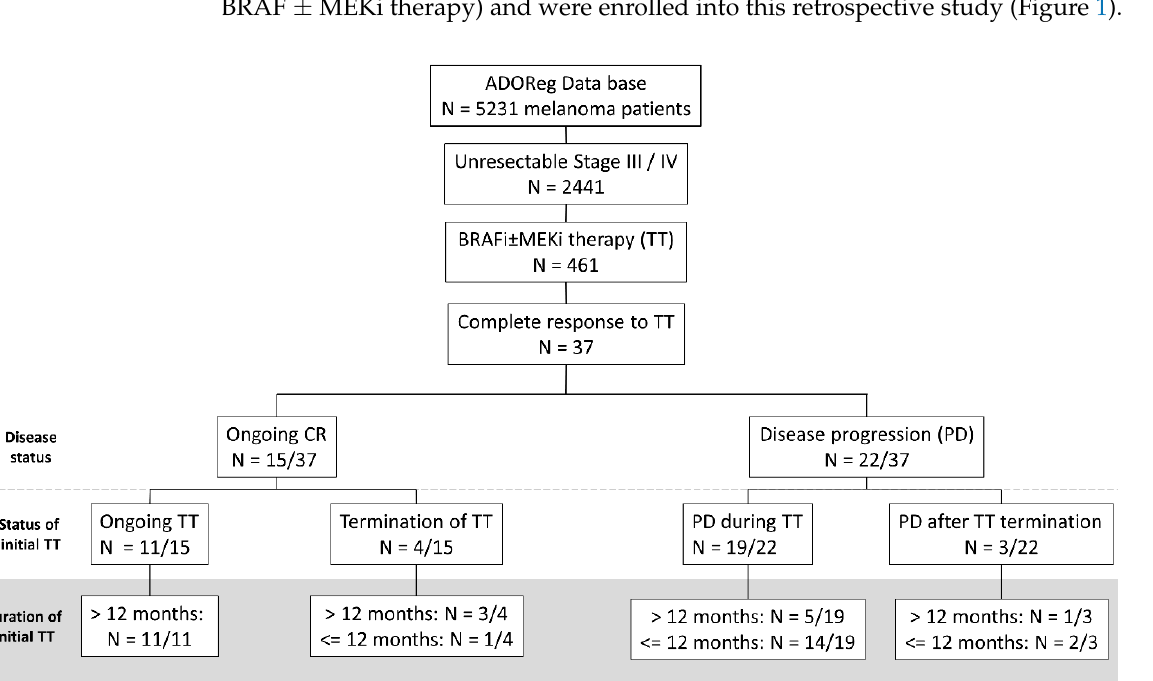
Figure 1. Flow chart showing the selection steps of the retrospective study and the treatment outcomes of melanoma patients after an initial CR to BRAF/MEKi therapy. We included all patients with an unresectable stage III / IV melanoma receiving BRAF/MEK-inhibitor (i) therapy who showed an initial complete response (CR) (n = 37). Among these 37 patients, 40.5% experienced an ongoing CR, whereas 59.5% showed disease progression during follow-up. 11 patients who showed an ongoing CR continuously received BRAF ± MEKi therapy, whereas 4/15 patients discontinued TT previously, but yet showed an ongoing CR. Notably, most patients with an ongoing CR received initial BRAF ± MEKi therapy for a longer interval than 12 months. By contrast, patients showing a disease progression after initial CR, received BRAF ± MEKi therapy for less than 12 months and most patients experienced disease progression (PD) during BRAF ± MEKi